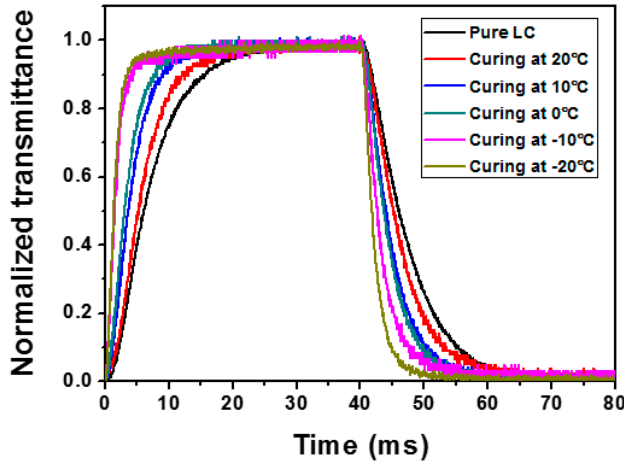
Figure 2. Measured optical switching behaviors of a conventional IPS cell and polymer-stabilized IPS cells cured at 20, 10, 0, − 10, and − 20 °C.